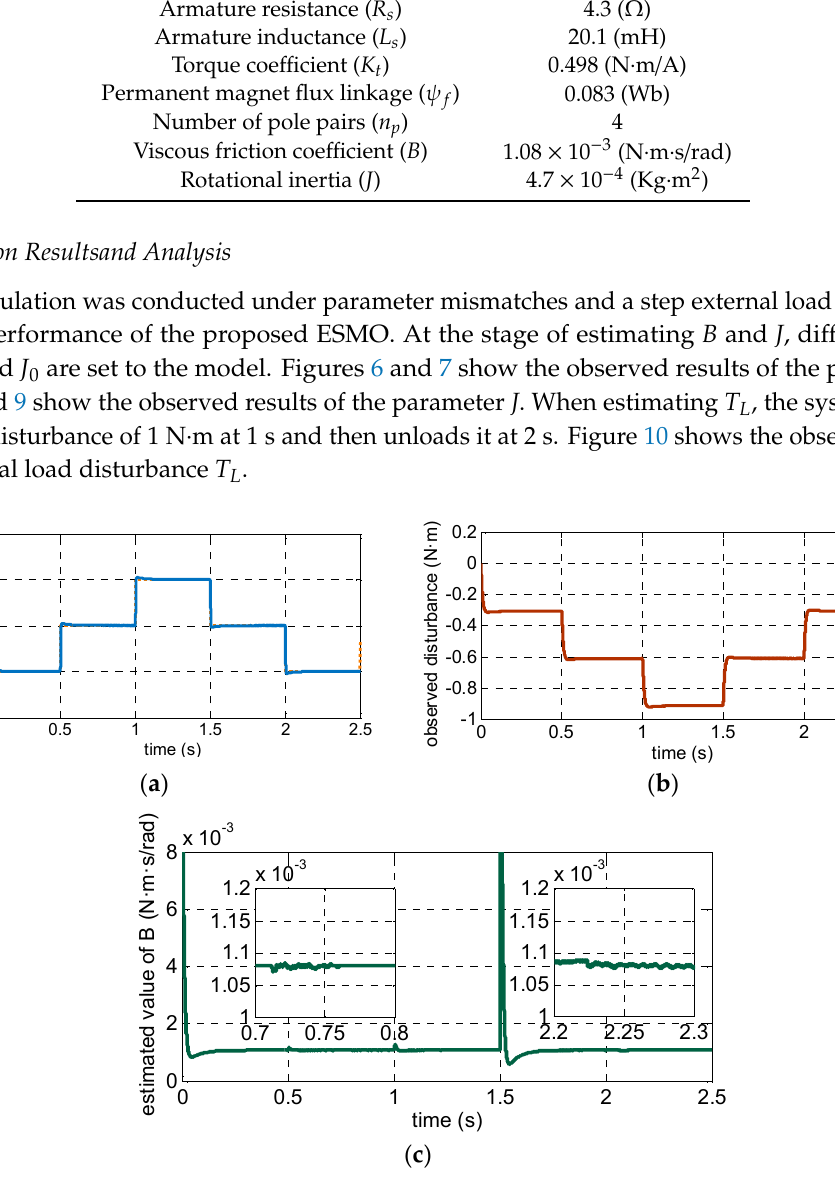
Figure 6. Simulation results under a speed step of ±300 rpm for B 0 = 10 B : ( a ) Measured speed, ( b ) observed disturbance value for parameter mismatch error Δ B , ( c ) estimated value of parameter B .